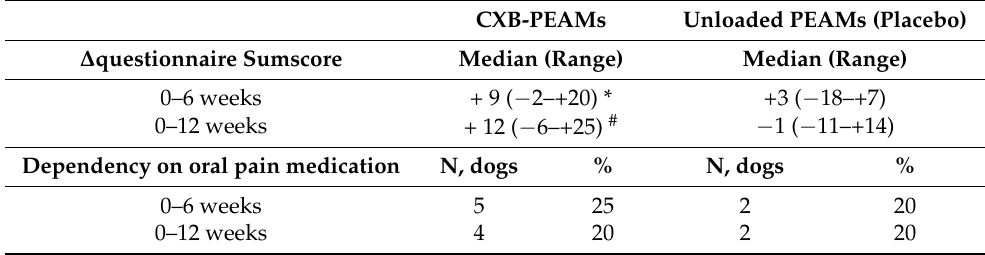
Table 3. Primary outcome of 30 dogs suffering from degenerative lumbosacral stenosis treated with intradiscal injection of celecoxib-polyesteramide microspheres (CXB-PEAMs) or unloaded PEAMs